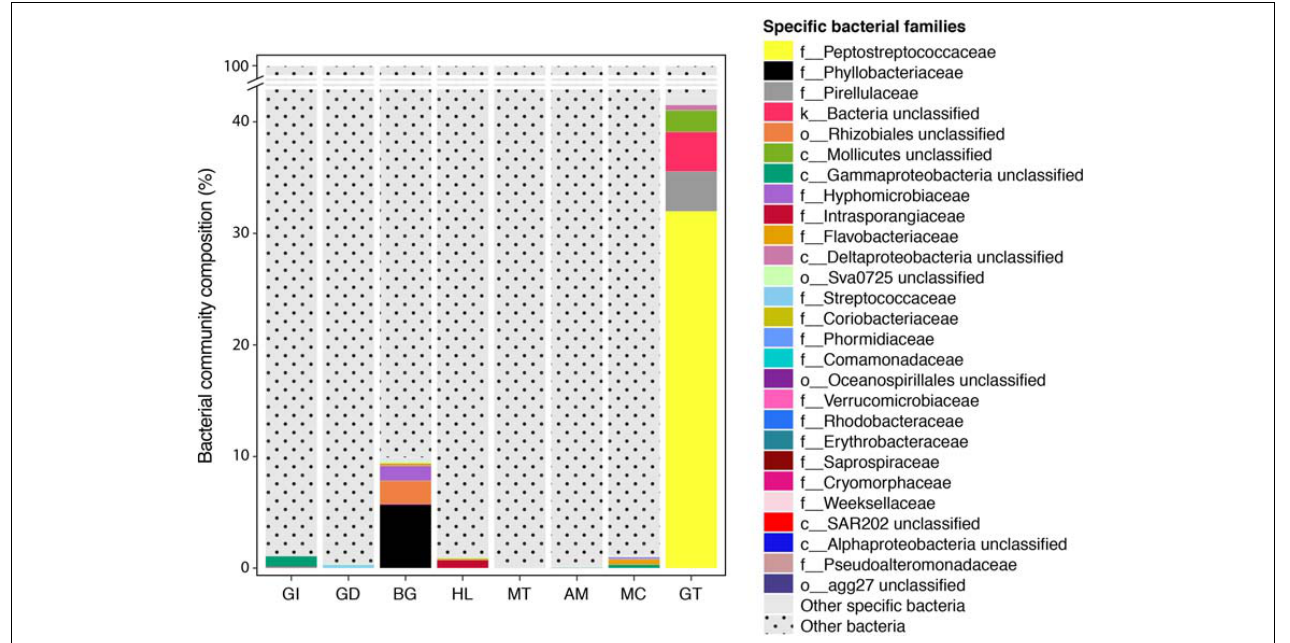
FIGURE 5 | Indicator bacterial families for variation in bacterial communities between P. margaritifera tissues. Specific bacterial families associated with each tissue. Bar plots represent the average relative abundance of each identified specific bacterial OTU at the family level; dotted bars are none specific OTUs.